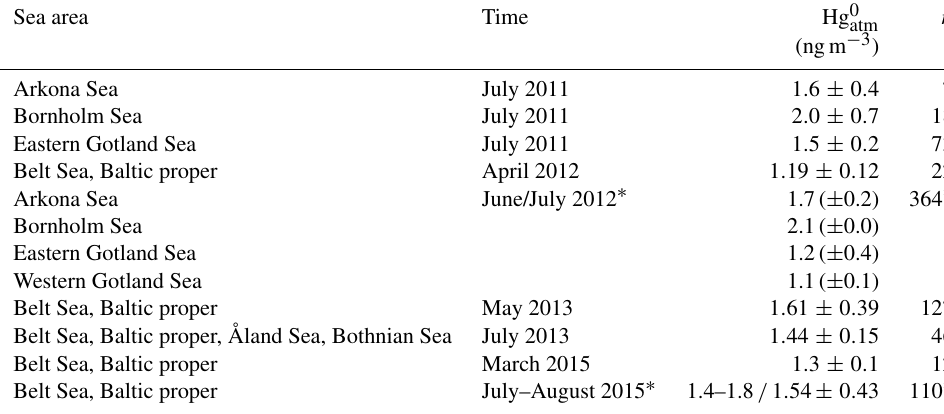
Table 1. Measured atmospheric Hg 0 concentrations were averaged or fitted versus time for the Hg 0 flux calculations.